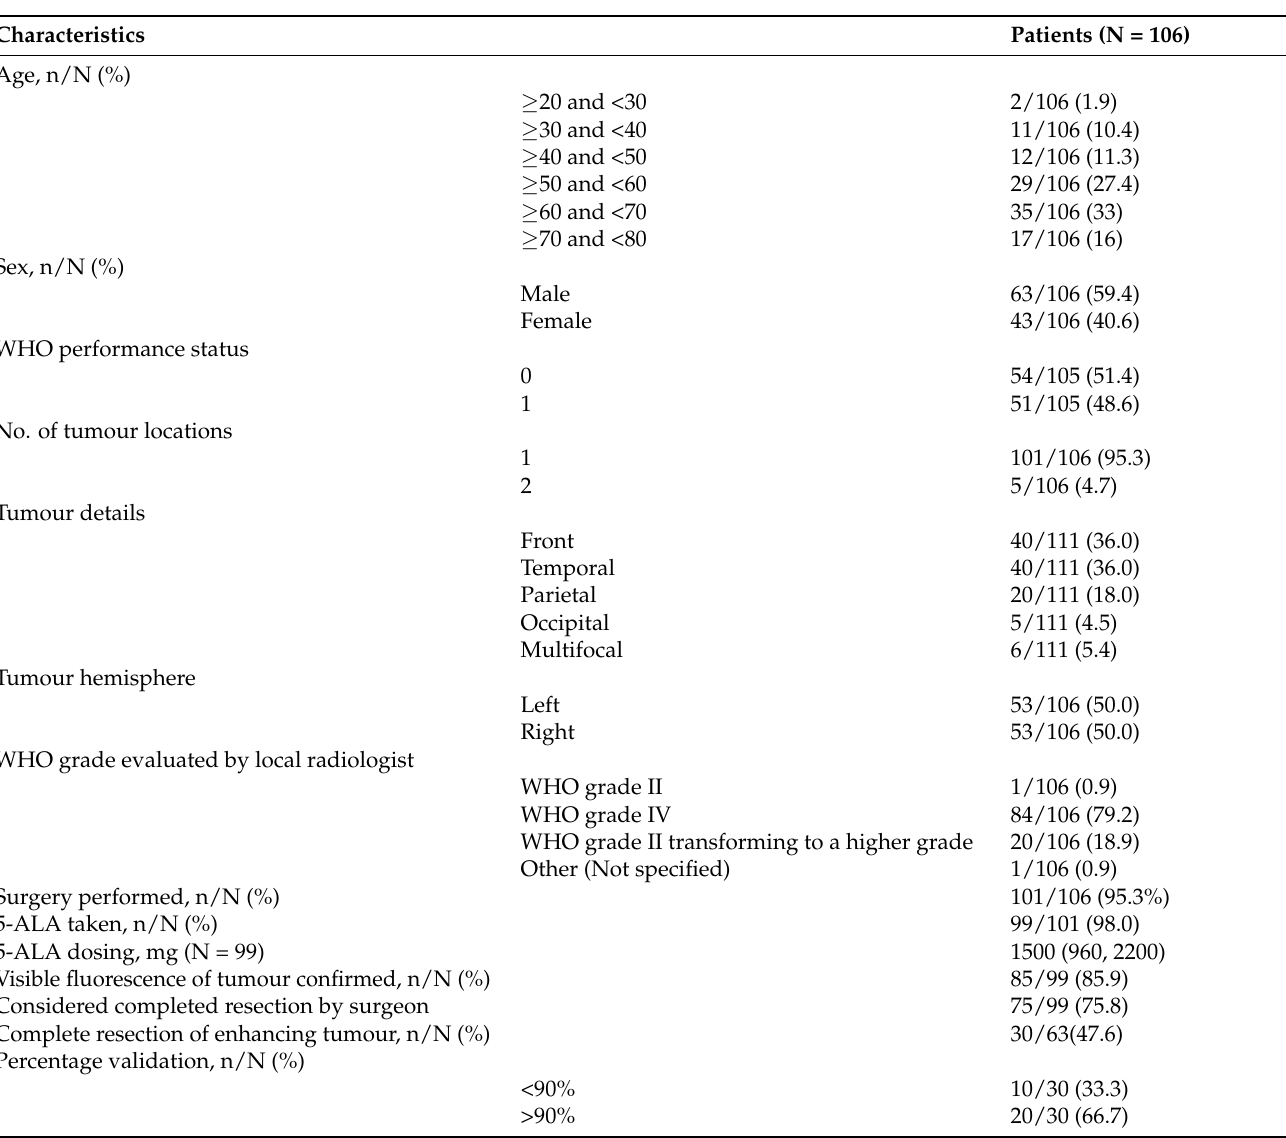
Table 1. Baseline Characteristics and Surgical Details of patients